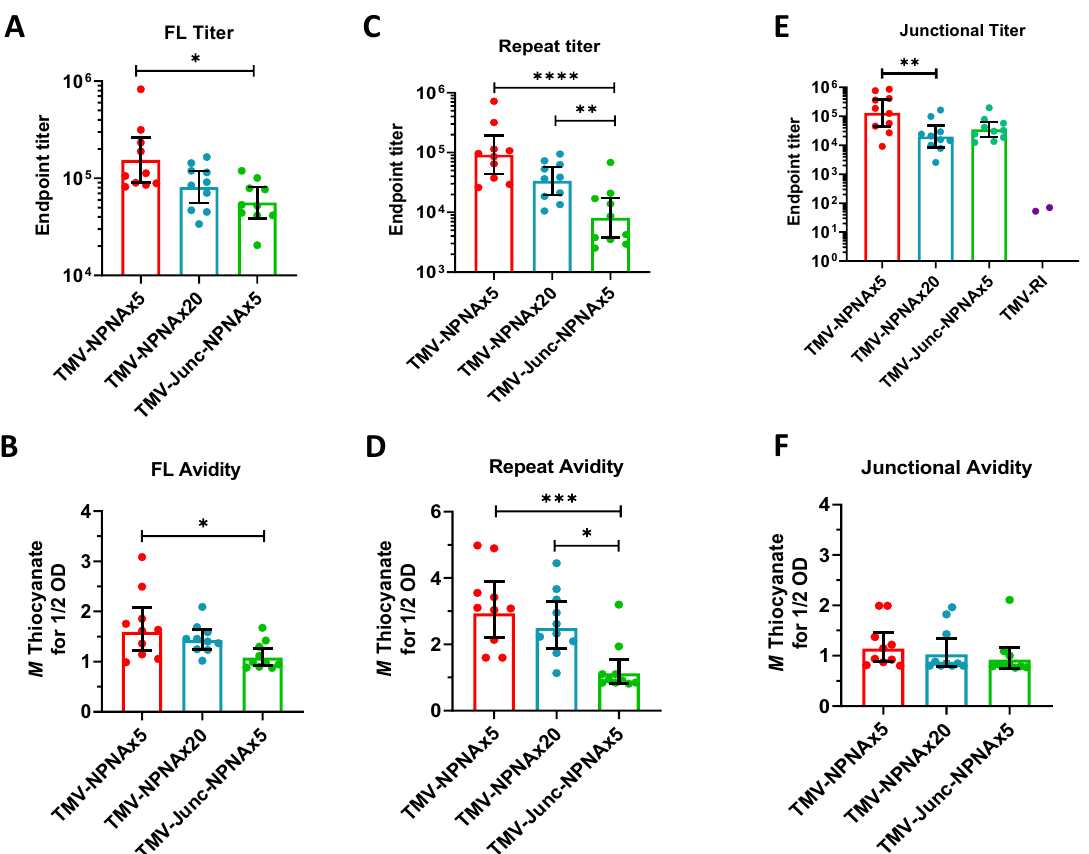
Fig. 7 Study 2 geometric mean titers and avidity. At 5WP3 against FL-CSP ( A , B ); against NANPx6 ( C , D ); and junctional peptide ( E , F ). Bars are geometric mean ± 95% CI. Statistical signi fi cance between groups was determined by one-way ANOVA followed by Tukey ’ s correction; **** ( p < 0.0001), *** ( p < 0.001), ** ( p < 0.01), or * ( p < 0.05).